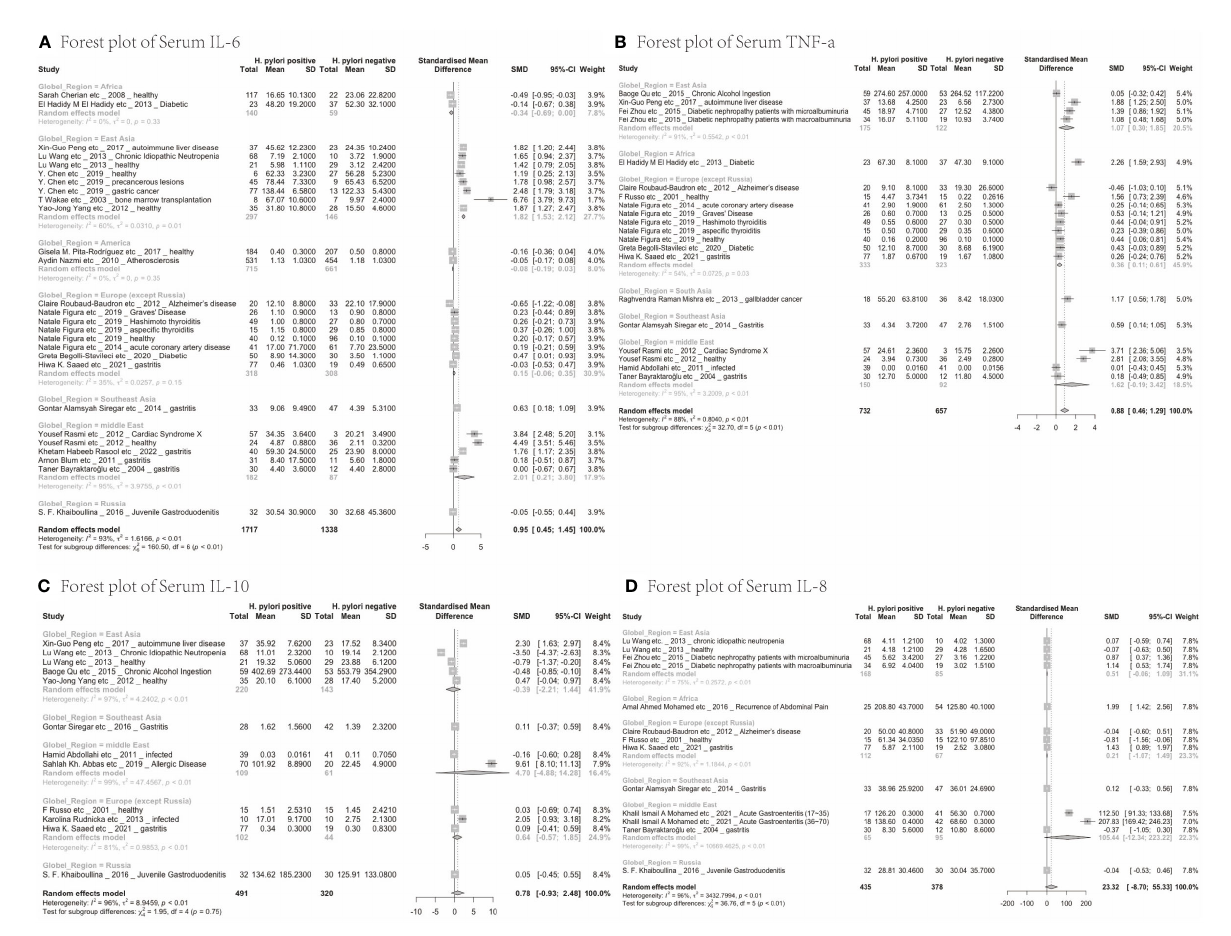
FIGURE 2 Forest plots of the meta-analysis of the effect of H. pylori infection on serum cytokines levels in different global regions. (A) IL-6 (B) TNF-a (C) IL-10 (D)